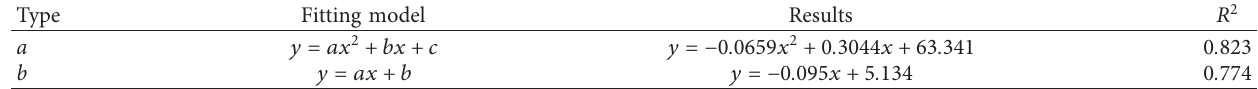
Figure 6: Graphs of porosity and strength. (a) Graph of porosity and compressive strength. (b) Graph of porosity and tensile strength. Table 14: Fitting results of mathematical expressions of porosity and strength.